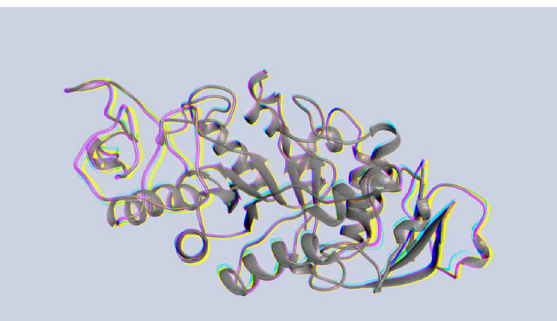
Figure 4: A sample skeleton introduced for α -amylase (pdb 1AMY). These bones represent motions converted for the normal mode analysis, and the molecular dynamics trajectory is demonstrated on our web page [20]. In the loop regions, bone motions frequently become larger than those in the other regions. In that case, smaller bones should be used for smoother animation.